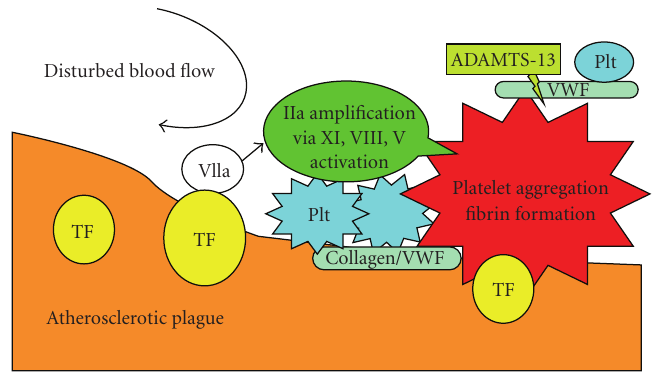
Figure 8: Schema of atherothrombus growth. Atherothrombus formation is initiated by plaque disruption and exposure of matrix proteins and tissue factor (TF). This induces initial platelet (Plt) adhesion/aggregation and activation of coagulation cascade. Thrombin (IIa) activates factor XI, factor VIII, and factor V on activated platelets, which amplify thrombin generation. Excess thrombin generation enhances fibrin formation and platelet aggregation on atherosclerotic plaque. The thrombin-dependent thrombus formation is mediated by plaque TF. Disturbed blood flow also promotes coagulation cascade and platelet recruitment by von Willebrand factor (VWF). The platelet recruitment is negatively regulated by ADAMTS-13 (a disintegrin and a metalloprotease with a thrombospondin type 1 motif